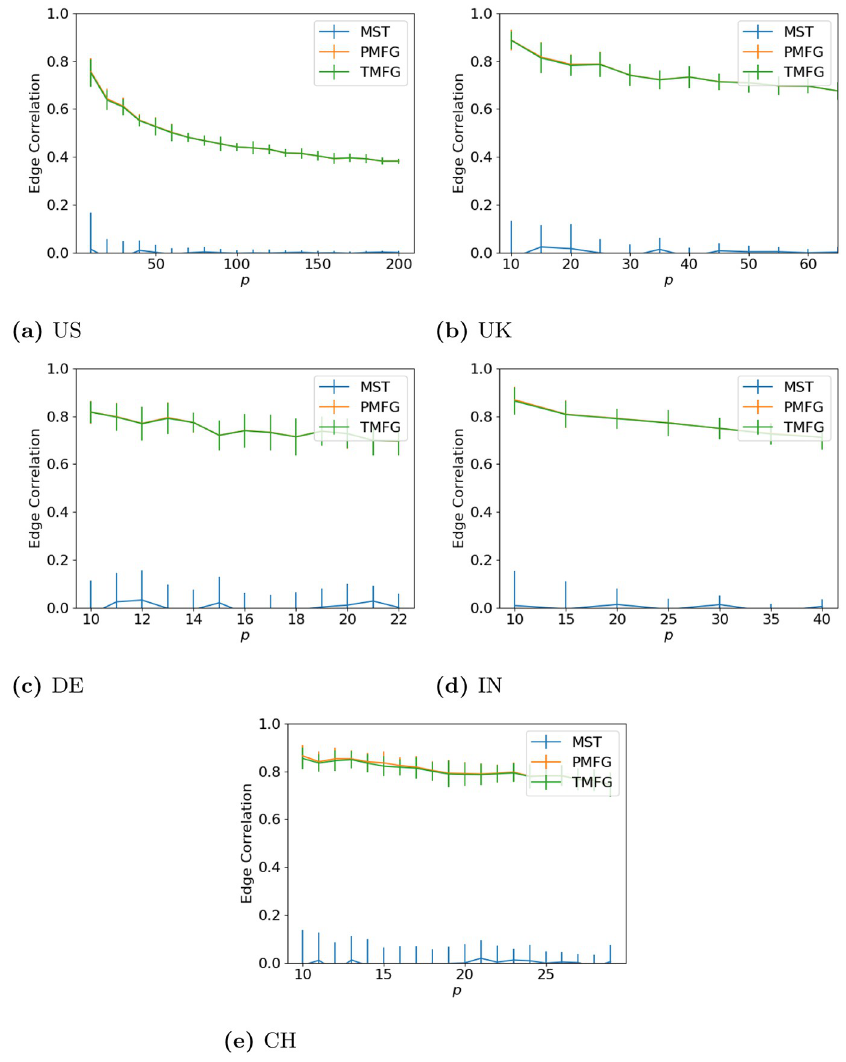
Fig 5. Agreement between edges between the full and filtered correlation matrices with different values of p for the window with maximum volatility. (a) US, (b) UK, (c) DE, (d) IN, (e) CH.